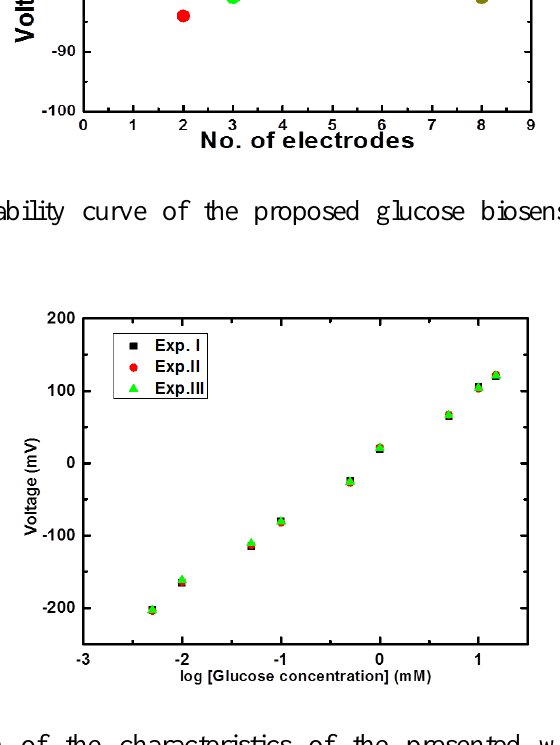
Table 1. Comparison of the characteristics of the presented work and some other previously reported glucose